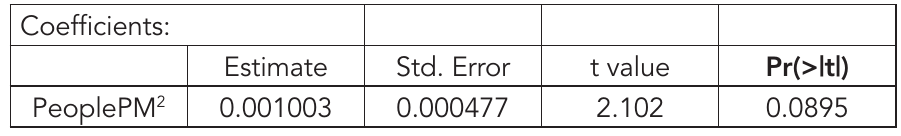
Table 7: Regression results for estimating noise cost as